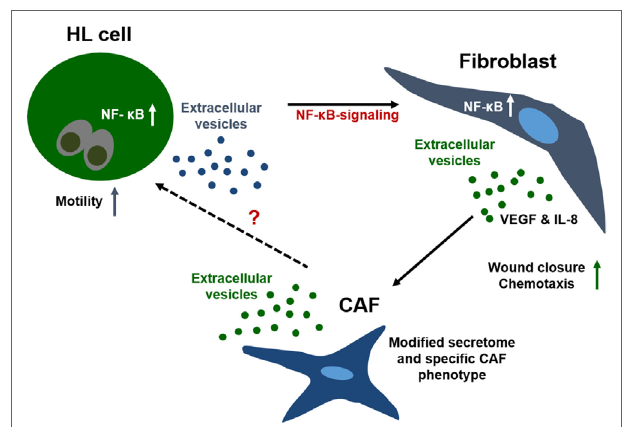
FigUre 4 | Interaction of fibroblasts and Hodgkin lymphoma (HL) cells in the tumor microenvironment. Communication of the few malignant cells in HL with fibroblasts is crucial for survival of the tumor cells. Due to the spatial distance between the cells, direct cell–cell interaction is not the first-line communication mechanism. Interaction of both cell types is facilitated by soluble and vesicular factors, e.g., chemokines/cytokines, which enhance motility and migration of cells. Further, HL extracellular vesicles shape the phenotype of fibroblasts, skewing the cells to a cancer-associated cell state concomitant with alteration of their secretome. Our results suggest a strong involvement of the TNF- α /NF- κ B axis in this